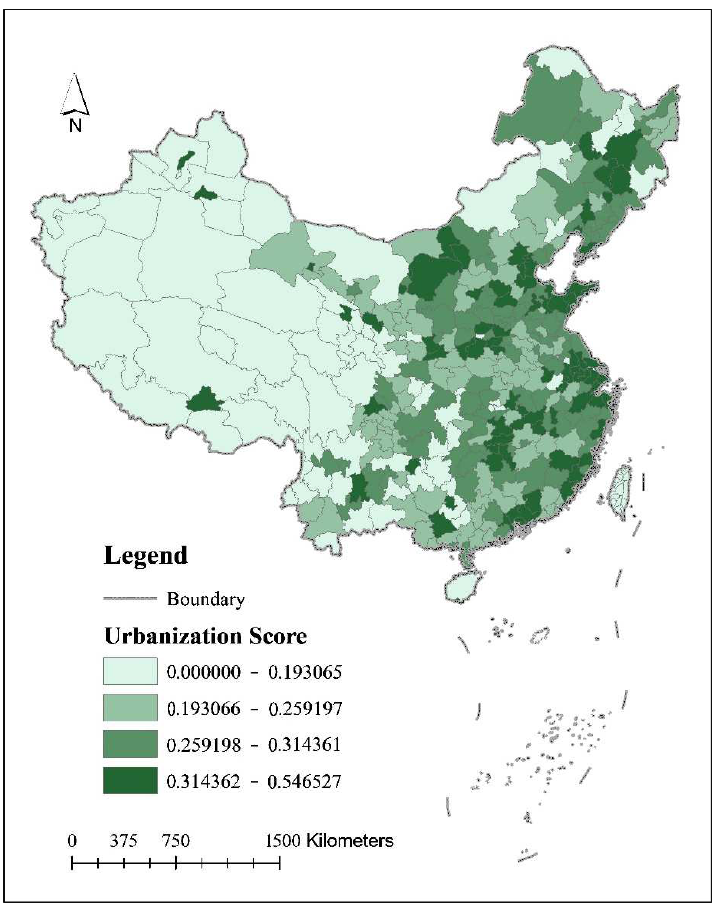
Figure 4. China’s urbanization level composite score. Table 5. Secondary indicators score of